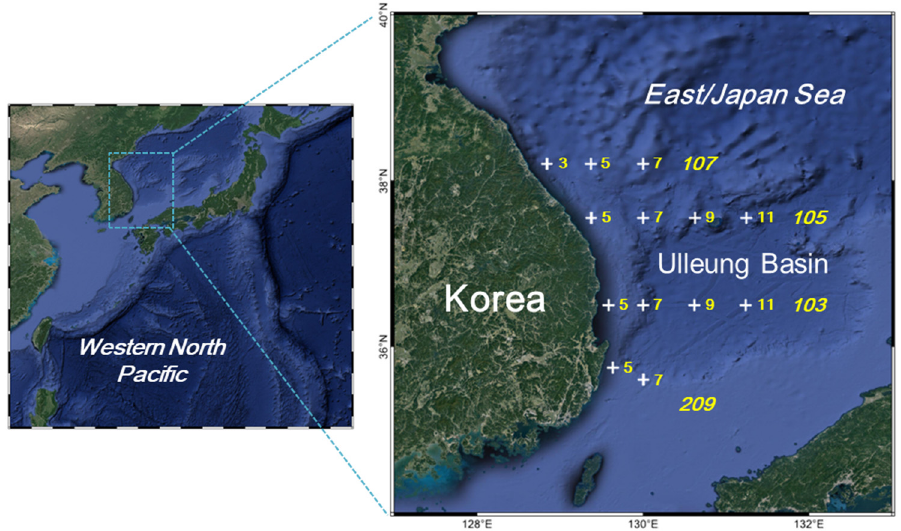
Figure 1. Pelagic fish egg sampling stations in the East/Japan Sea, 2019–2021. Numbers with plus marks, station name; italic number, station lines. The base map is a Google Satellite map drawn using QGIS [27] through the XYZ Tiles tool (https://mt1.google.com/vt/lyrs=s&x={x}&y={y}&z={z}, accessed on 10 March 2022).